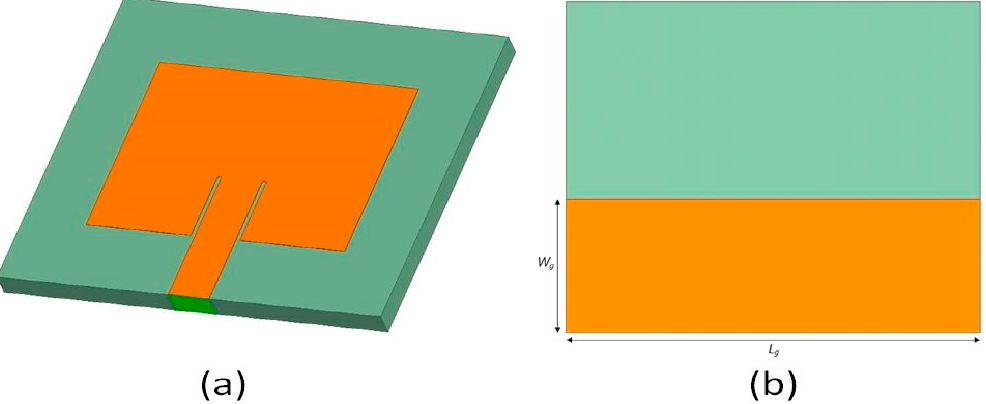
Figure 1. ( a ) Three-dimensional view and ( b ) partial ground plane of the proposed X-band MPA.